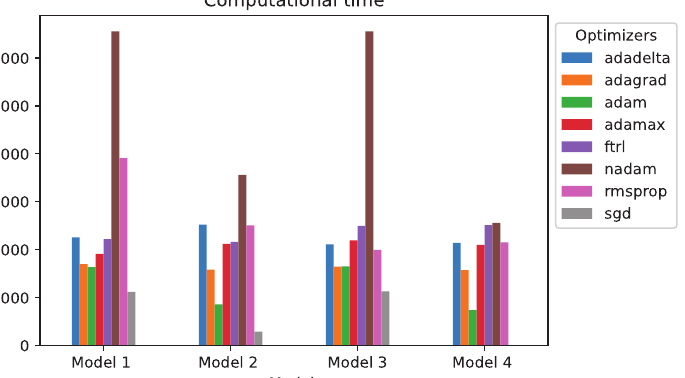
Figure 7. Computational time of different optimizers marked by different colors (blue, orange, green, red, violet, brown, pink, gray) for Case II, δ frequency, all EEG